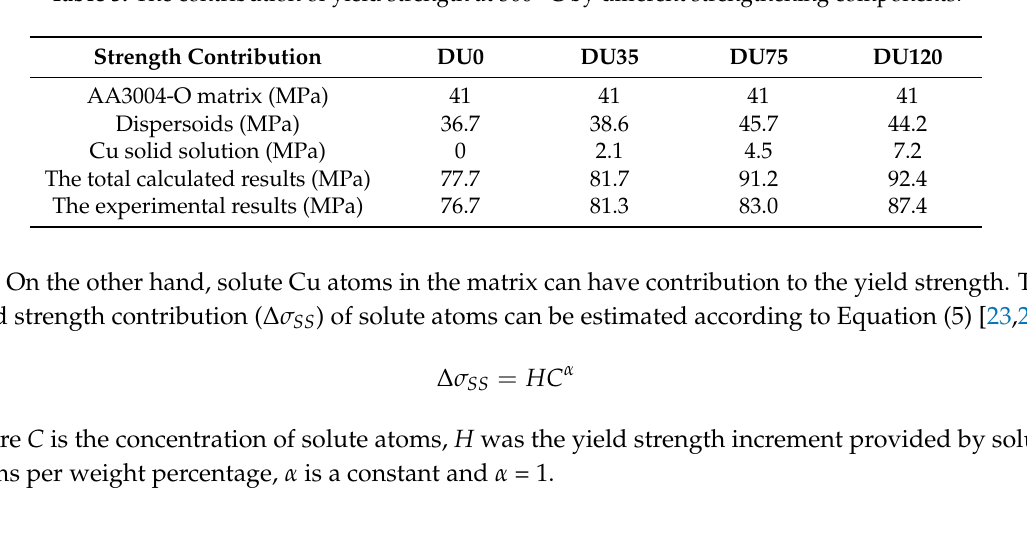
Table 3. The contribution of yield strength at 300 ◦ C by different strengthening